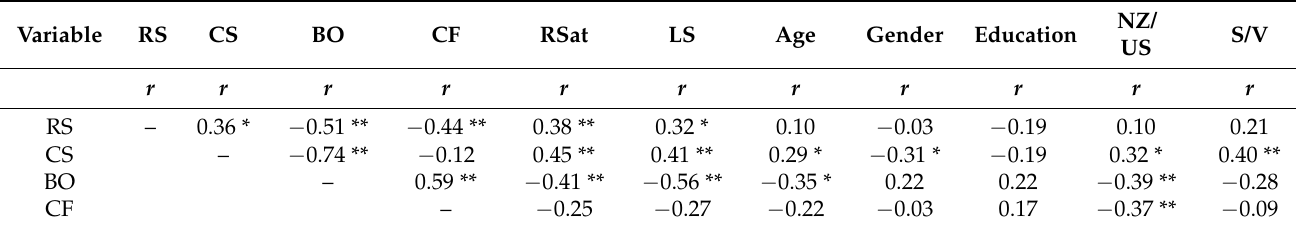
Table 5. Relationships between demographic and group characteristics with resilience, compassion satisfaction, burnout and compassion